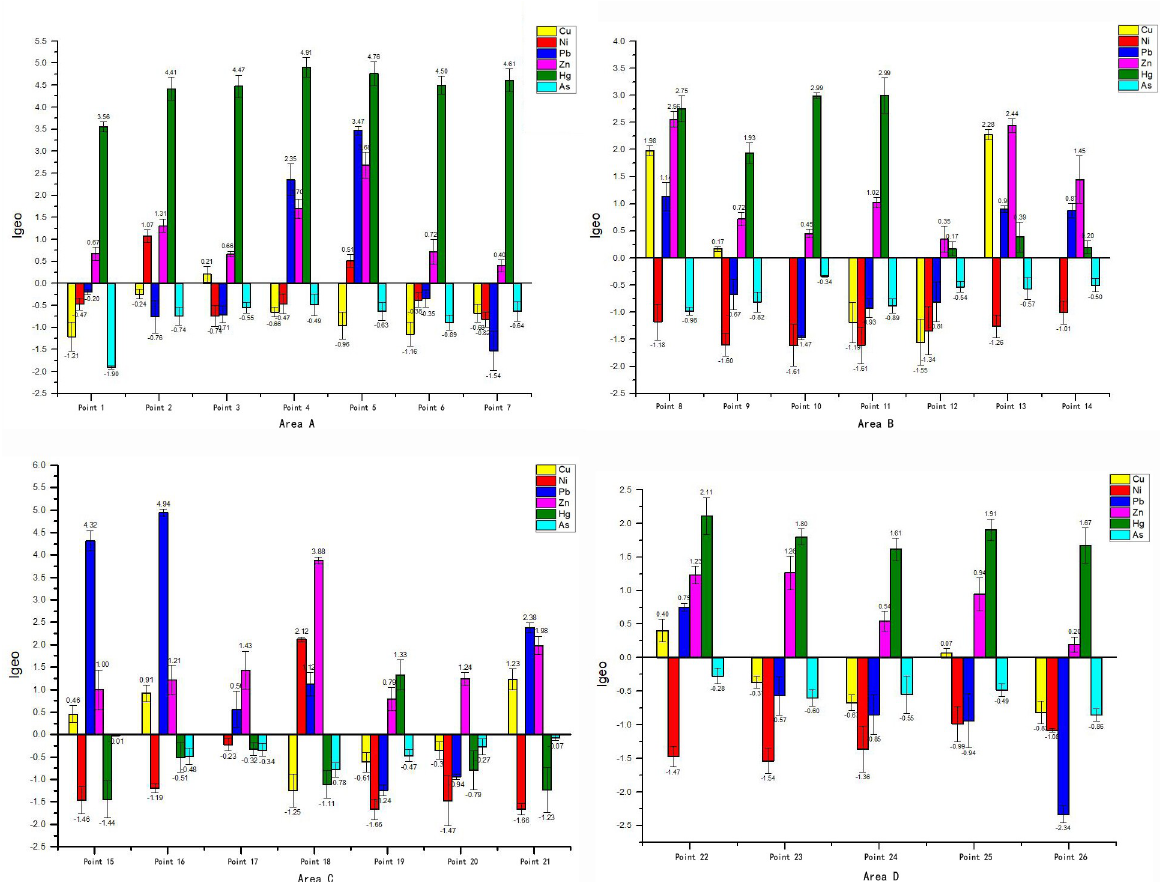
Fig 3. I geo distribution of heavy metals of each sample point in area A, B, C, D.